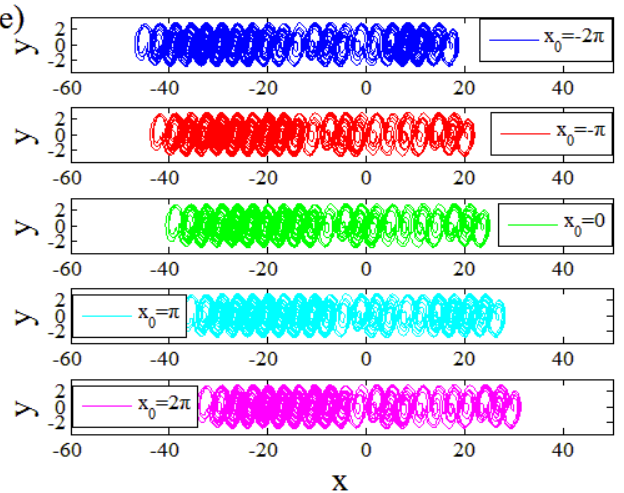
Figure 6. Multi-stable dynamics of the ( a ) single scroll period-2 when c = 0.95; ( b ) single-scroll chaos when c = 1.1; ( c ) double-scroll chaos when c = 1.25; ( d ) double-scroll period-4 when c = 1.58; ( e ) multi-scroll chaos when c = 1.8.